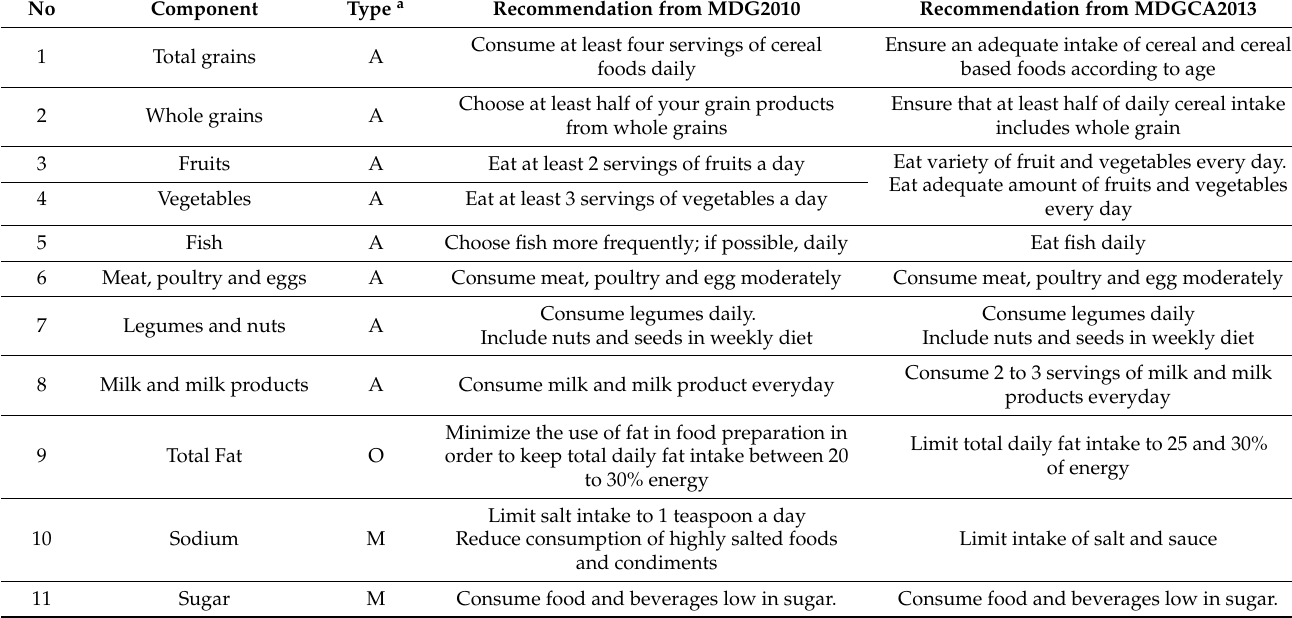
Table 1. S-MHEI’s components and related MDG2010 and MDGCA2013